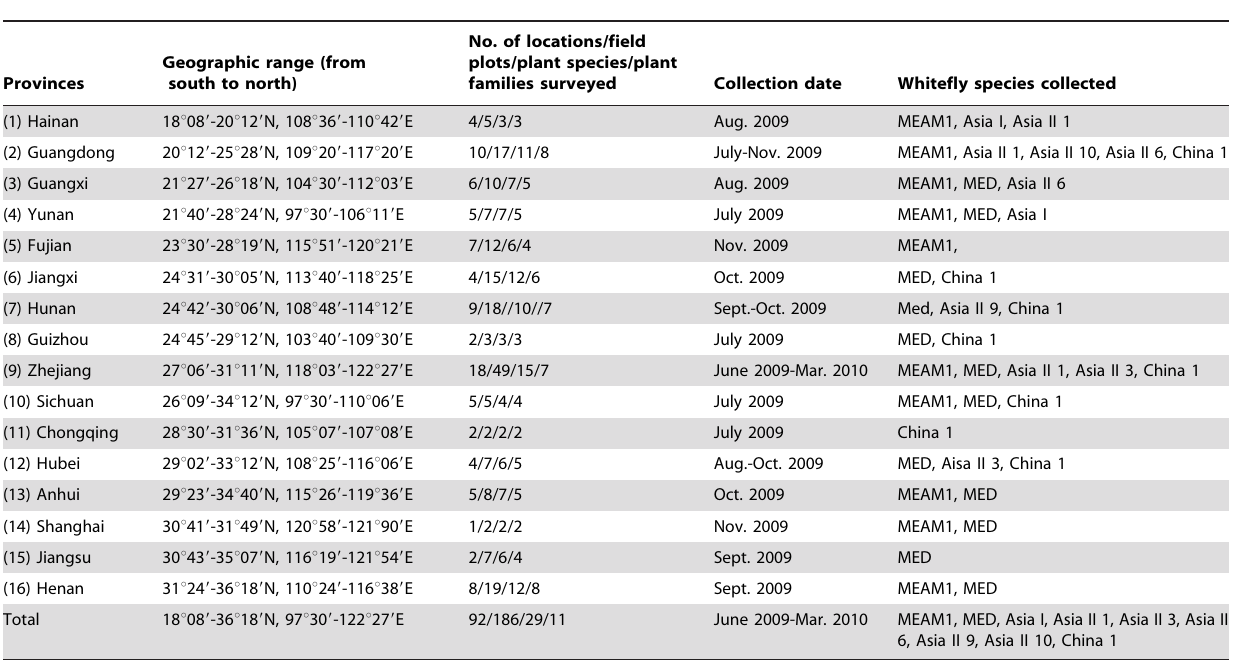
Table 1. A summary of the field survey dataset (See Table S1 for details on the collection locations, hosts, collection dates, species and accession numbers of B. tabaci mtCO1